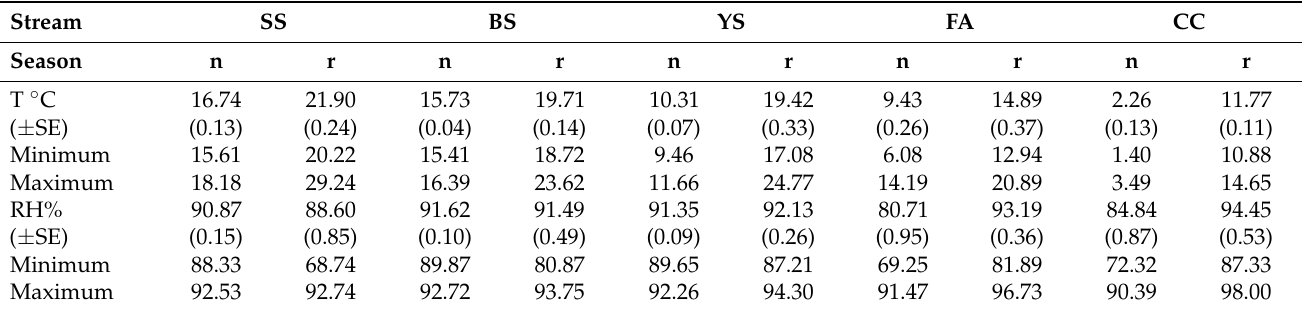
Table 2. Mean, standard error ( ± SE), minimum and maximum values of air temperature (T ◦ C) and relative humidity (RH) of the five study sites in the Sierra de Ju á rez, Oaxaca, Mexico. n = “nortes”, r = rainy. N =